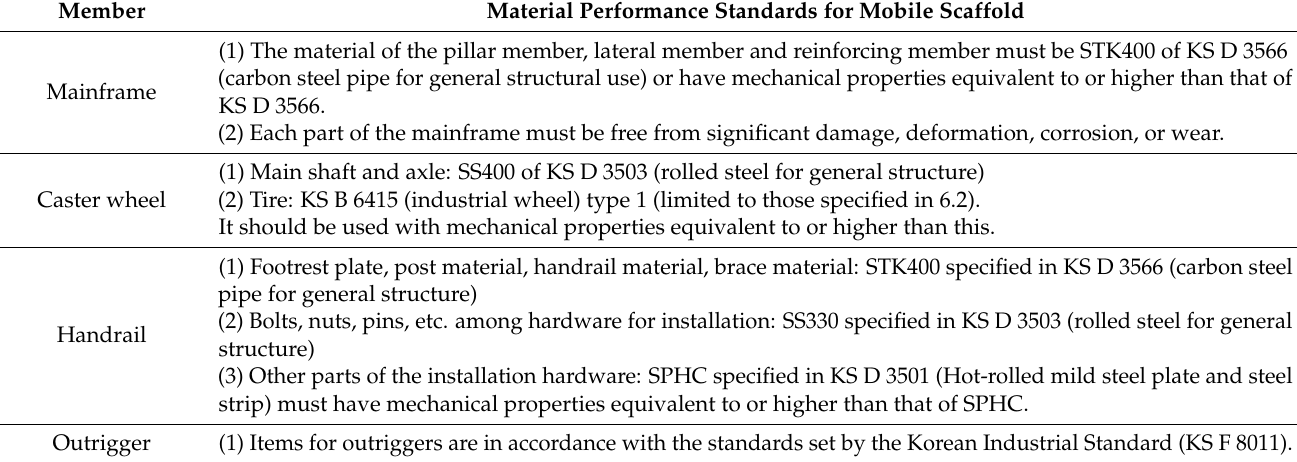
Table 5. Material performance standards for mobile